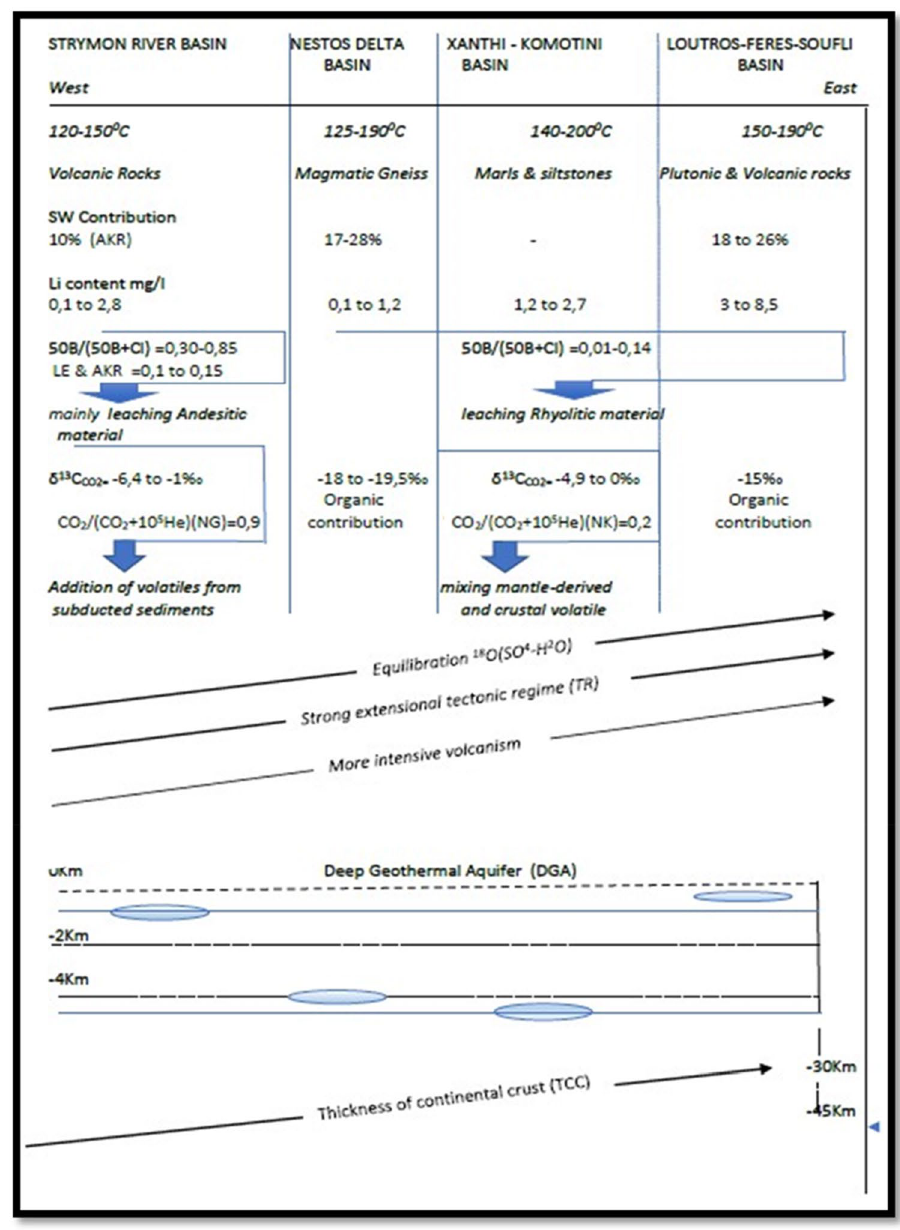
Figure 8. Schematic diagram summarizing the relevant characteristics of geothermal fields in North and Northeastern Greece. *See Shimizu et al. (2005) 44